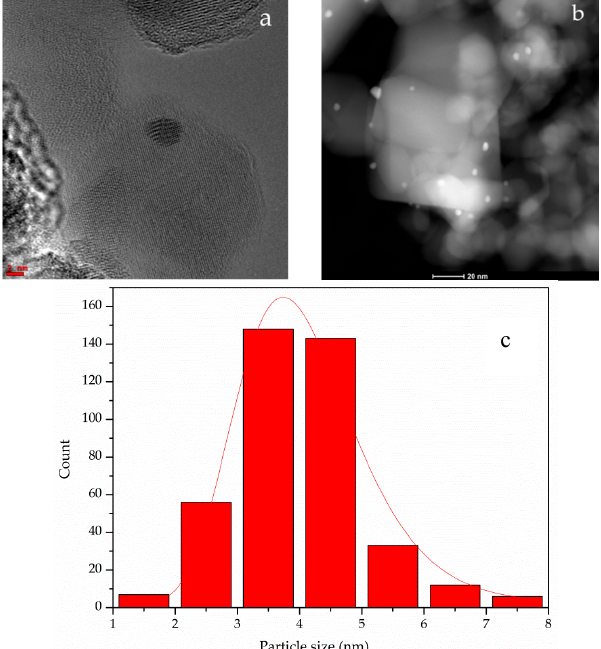
Figure 4. Representative HRTEM ( a ) and STEM ( b ) images; particle size distribution ( c ). Sample 0.2 wt% Au-P25.